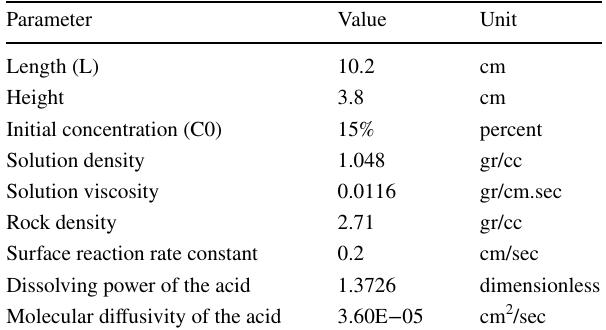
Fig. 5 Comparison of the results of Fredd and Fogler’s experimental study (1998) and the current model Table 2 Model input information in accordance with Fogler's experi-